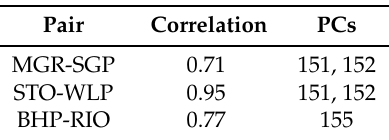
Figure 1. Scatter plots of relative weights of each stock in components 151 and 152 arising from a principal components analysis (PCA) on a correlation matrix from the whole study period. The lines join the origin to the point representing the coefficient in the 151th eigenvalue ( x -axis) and 152nd eigenvalue ( y -axis). The stocks are colour-coded using the Industry Classification Benchmark Industry (ICB) classification. Financials are blue (33 stocks), Health Care are red (9 stocks), Industrials are yellow (24 stocks), Consumer Services are brown (19 stocks), Basic Materials are green (31 stocks), Oil & Gas are purple (16 stocks), Utilities are orange (5 stocks), Consumer Goods are black (9 stocks), Telecommunications are orchid (4 stocks), Technology are grey (6 stocks). Stocks with a loading of at least 0.2 in one of the PCs are labelled with their ticker symbol. From this scatterplot, we can conclude that there are six highly correlated stocks structured as three pairs: namely, STO and WPL, SGP and MGR, and BHP and CFX. Table 2. The correlations of stocks with near-linear relationships in principal components (PCs) 151, 152, and 155. See Figures 1 and